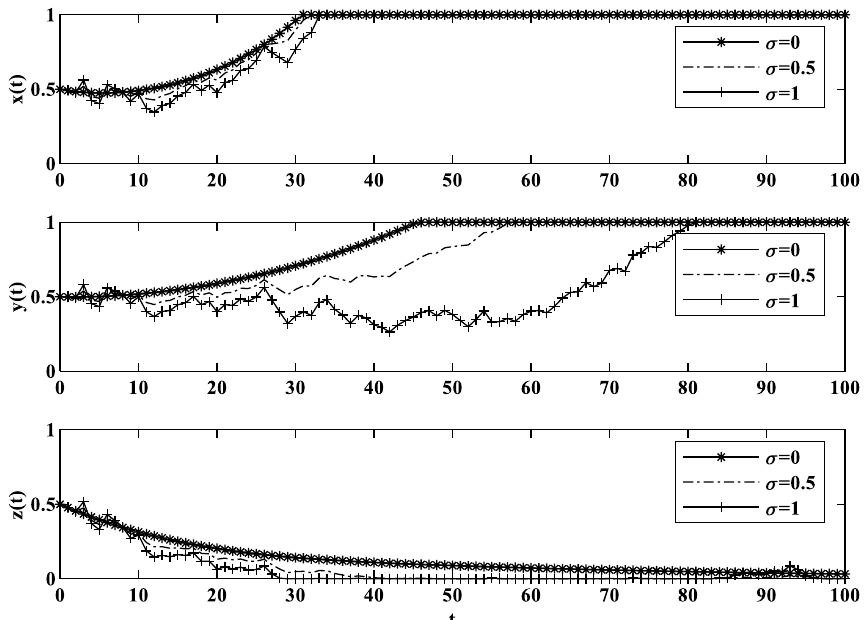
Fig. 16 Impact of disturbance intensity on evolutionary process under scenario